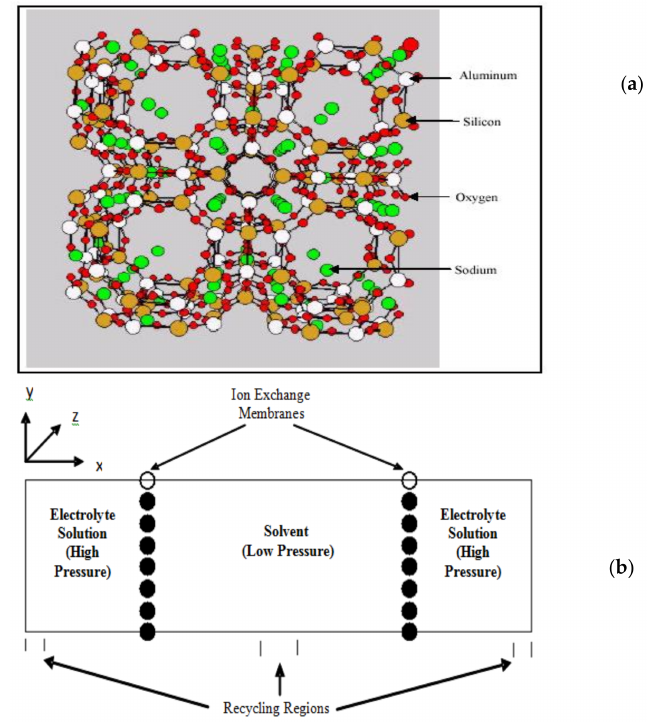
Figure 3. A typical system set up for ion exchange. ( a ) Zeolite membrane; ( b ) Two reservoirs and two membranes in conjunction with periodic boundary conditions are usually used in simulations as shown here.